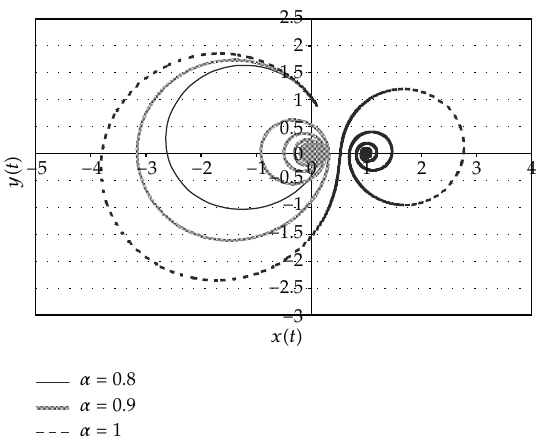
Figure 4: x (cid:2) 0 (cid:3) (cid:6) 0.1, y (cid:2) 0 (cid:3) (cid:6) 0.9, a (cid:6) 0.1, b (cid:6) 0.9.